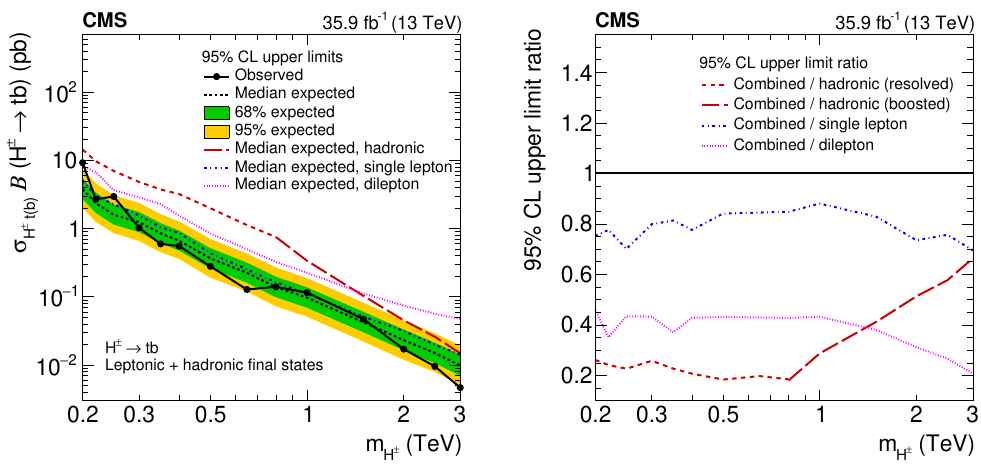
Figure 8 . Upper limits at 95% CL on the product of the H (cid:6) production cross section and branching B (H (cid:6) ! tb). The median expected limit fraction as a function of m for the process (cid:27) H (cid:6) H (cid:6) t(b) (dashed line), 68% (inner green band), and 95% (outer yellow band) con(cid:12)dence interval expected limits are also shown (left). The relative expected contributions of each channel to the overall combination are shown (right). The black solid line corresponds to the combined expected limits while the dashed, dotted and dash-dotted lines represent the contributing channels.